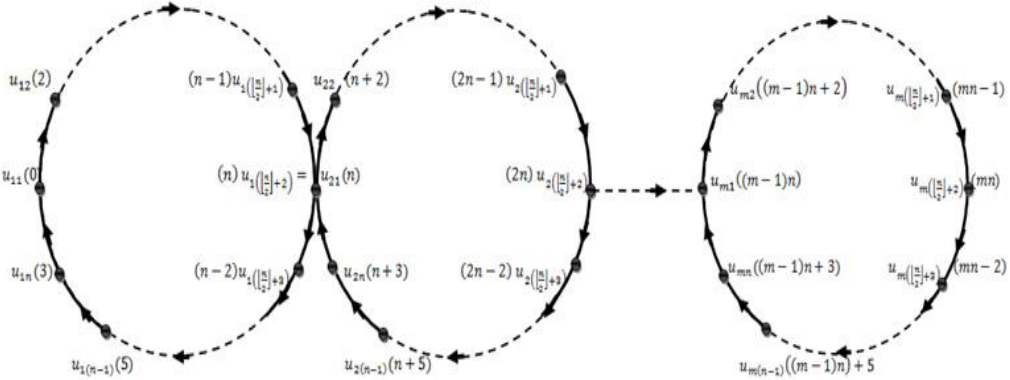
Figure 3.3: The labeling of the Di-cyclic Snake 𝑚𝐶